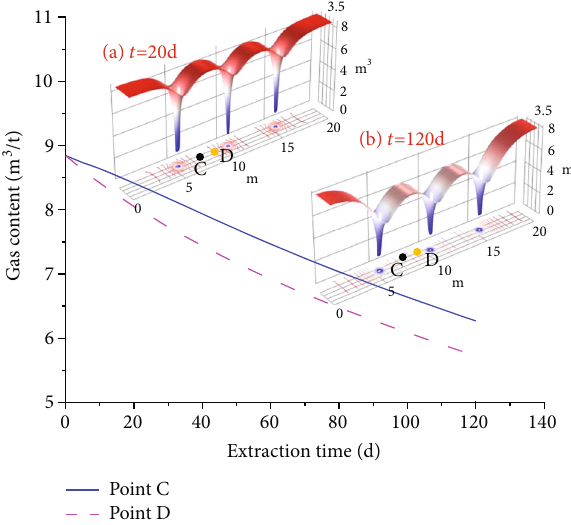
Figure 16: Variation of gas content with time when borehole diameter is 300